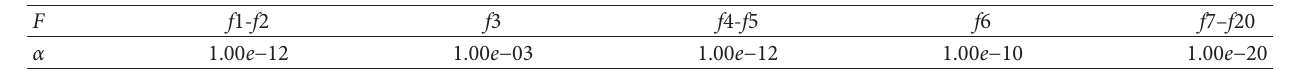
Table 2: The values of α in CEC’2010 special sessions on large-scale global optimization.